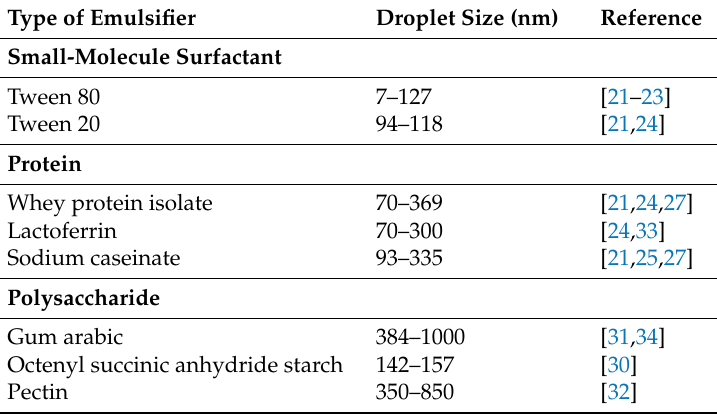
Table 1. Review of the published works reporting emulsions produced with different emulsifiers used in food